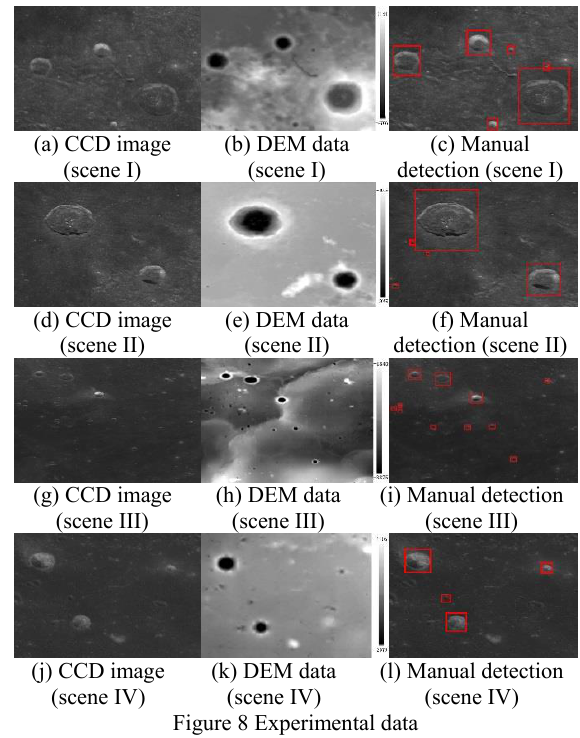
Figure 8 Experimental